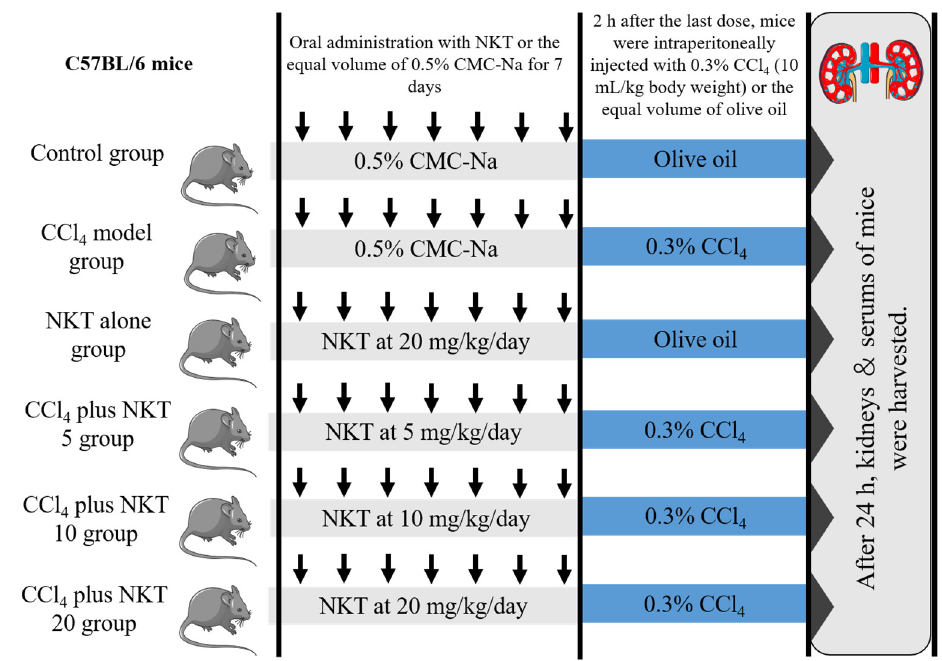
Figure 2. The schematic protocol for the experiment design.